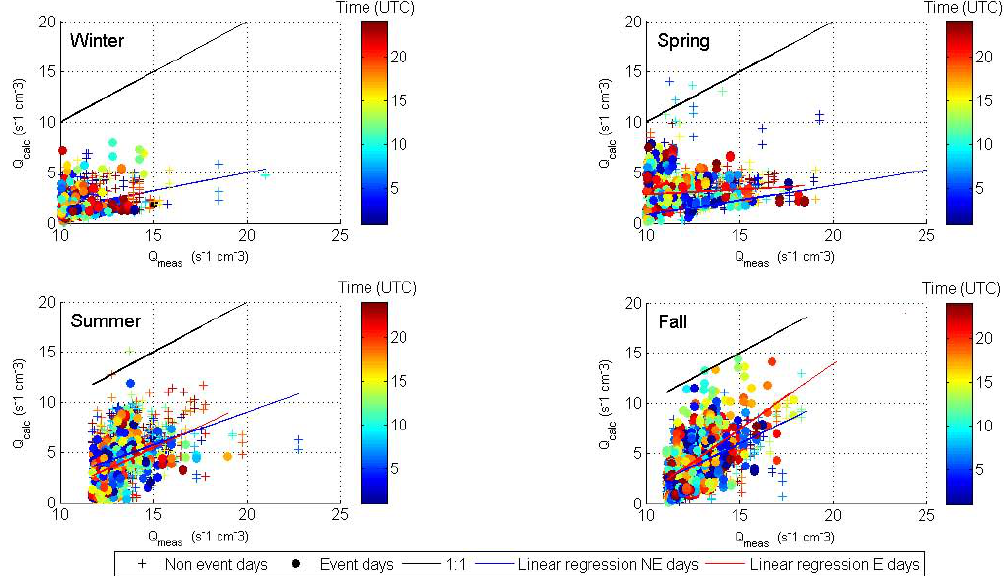
Fig. 13. Positive ionization rate derived from the balance equation versus estimated ionization from radon measured at the Puy de Dôme (February 2007–February 2012) and external radiation contribution (ie., GCR and gamma radiation) as a function of time. NPF event days and non-event days are plotted separately (dots and crosses,